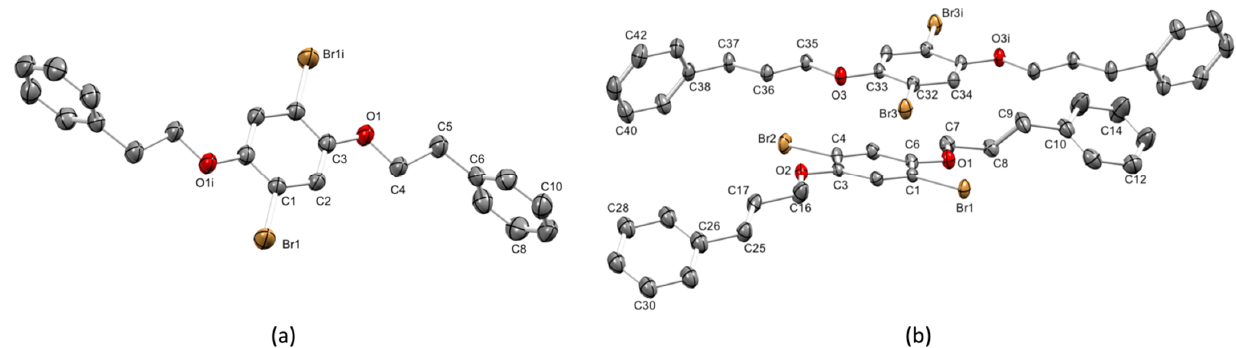
Figure 2. Molecular structures of ( a ) one of the crystallographically independent molecules of polymorph I of 1 (symmetry code i = − x , − y , − z ), and ( b ) the two independent molecules of 2 (symmetry code i = − x , 1 − y , 1 − z ). In 2 , the 3-phenylpropoxy chain with C26 is disordered and only one position is shown; see text and Figure S13. Ellipsoids are plotted at the 40% probability level and H atoms are omitted for clarity. Table 1. Selected bond lengths and angles in compounds 1 (polymorph I, for the molecule containing Br1) and compound 2 (both independent molecules A (with Br1 and Br2) and B (with Br3)).